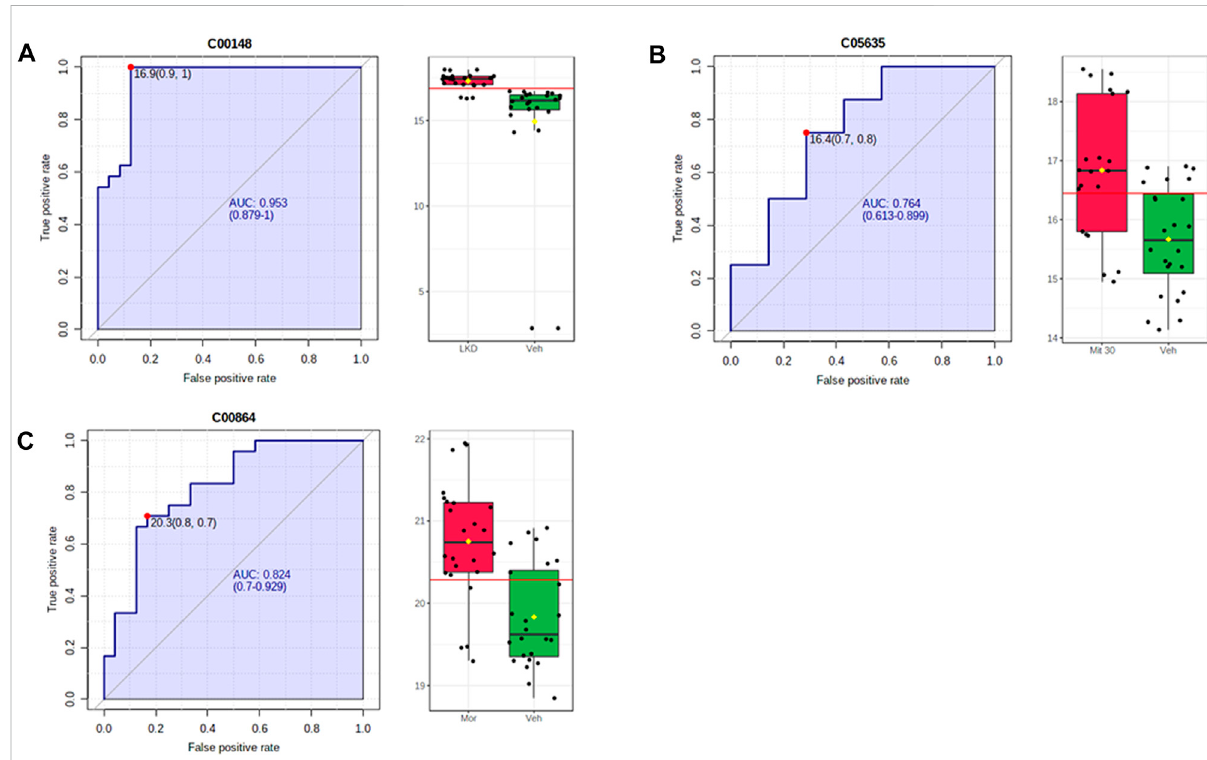
FIGURE 8 ROC-AUC analysis of the metabolites differentially expressed due to kratom exposure in adolescent rats. The analysis was performed using Metaboanalyst software, by comparing the vehicle- and morphine-treated group, mitragynine 3 mg/kg and 30 mg/kg, and LKD group. Several metabolites were identi fi ed to be potential biomarkers with AUC values higher than 0.7. (A) L-Proline, (B) 5-hydroxyindoleacetic acid, and (C) pantothenic acid.